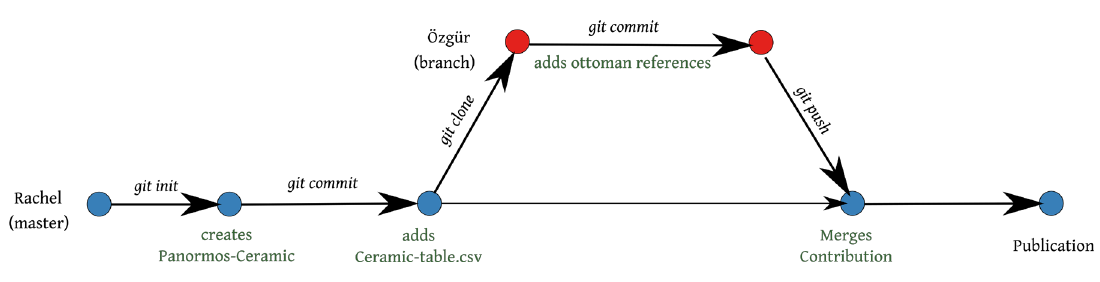
Figure 5. A simplified graphical representation of a